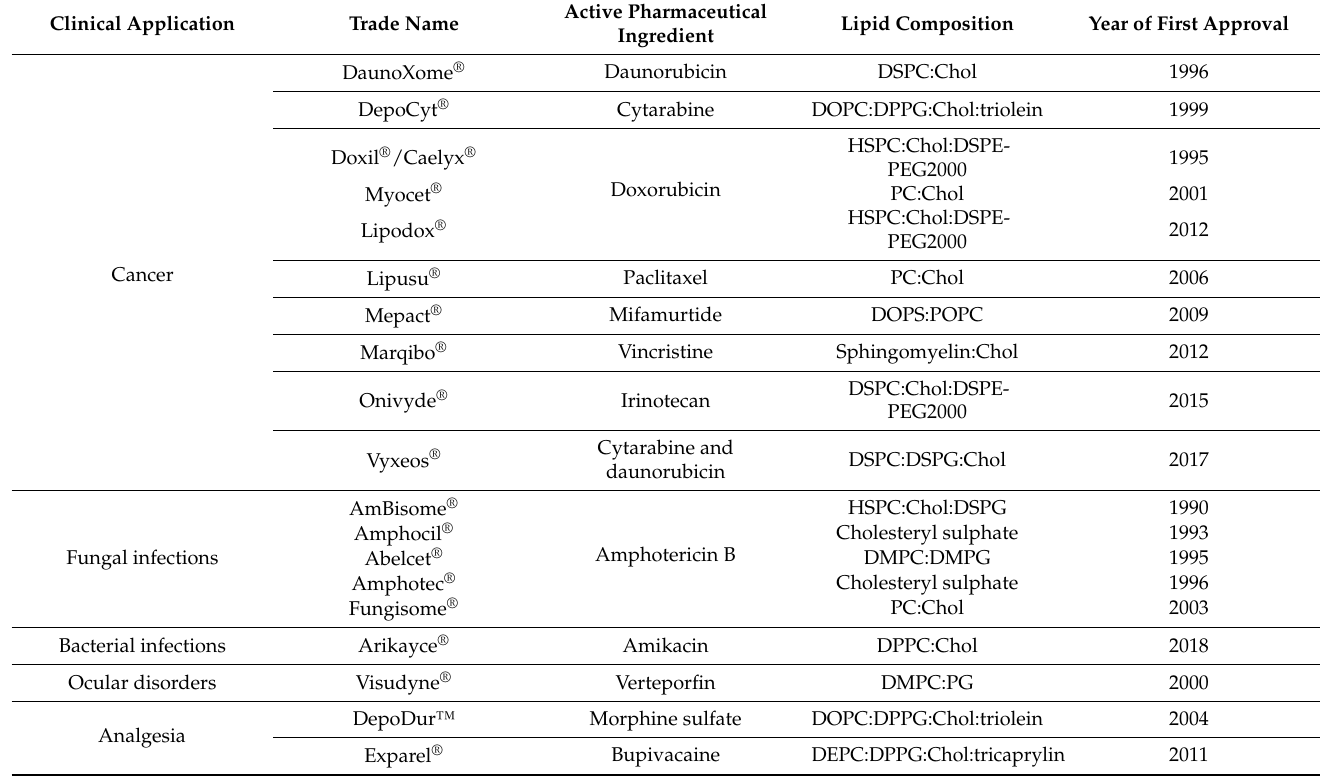
Table 4. Examples of liposomal formulations approved for clinical use